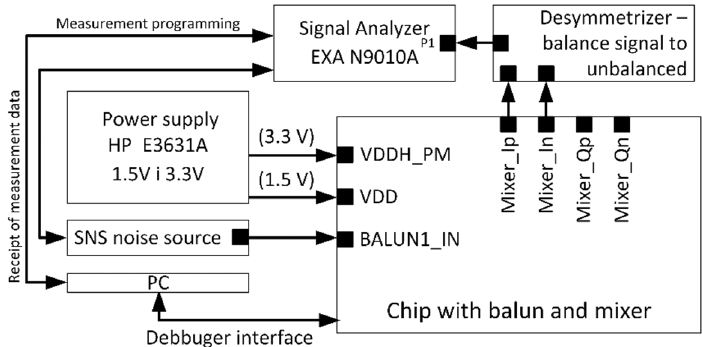
Figure 19. Environment for measuring the voltage conversion gain and noise figure of the balun and mixer.